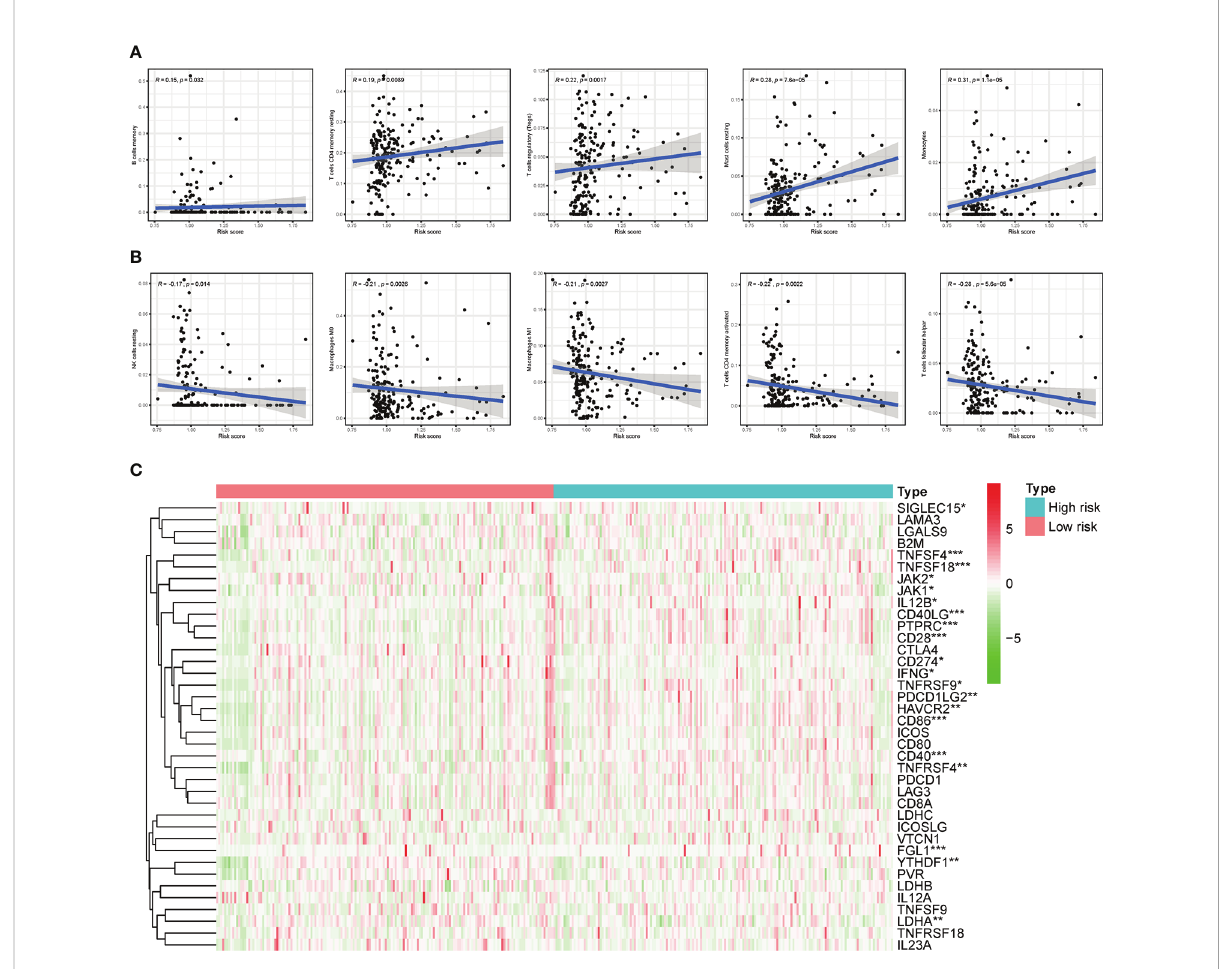
FIGURE 12 Correlation of subgroup with TME and ICGs. (A) The high-risk group has signi fi cant positive correlations with memory B cells, memory resting CD4 T cells, regulatory T cells, resting mast cells, and monocytes. (B) The high-risk group has signi fi cant negative correlations with resting NK cells, M0 Macrophages, M1 Macrophages, memory activated CD4 T cells, and follicular helper T cells. (C) The expression of ICGs between different risk subgroups. * p < 0.05, ** p < 0.01, and *** p <